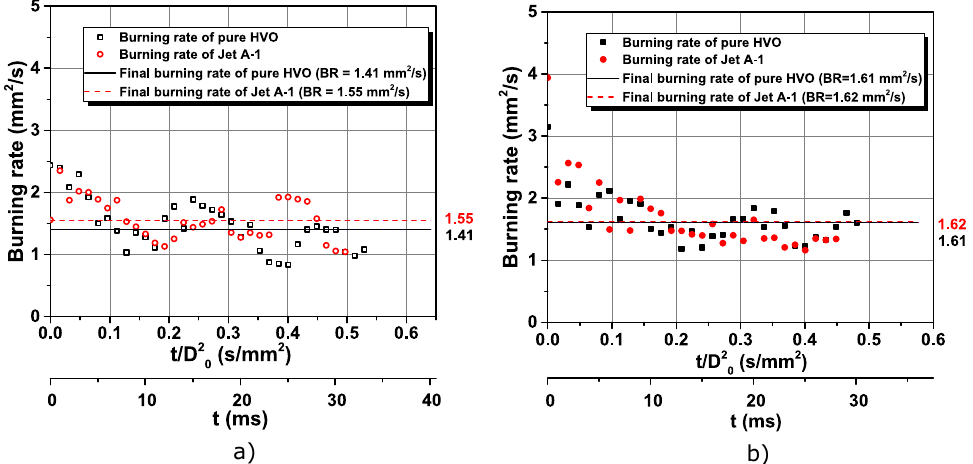
Figure 11. Temporal evolution of burning rate and final burning rate for the Jet A-1 and pure HVO at ( a ) T = 800 ◦ C and ( b ) T = 1000 ◦